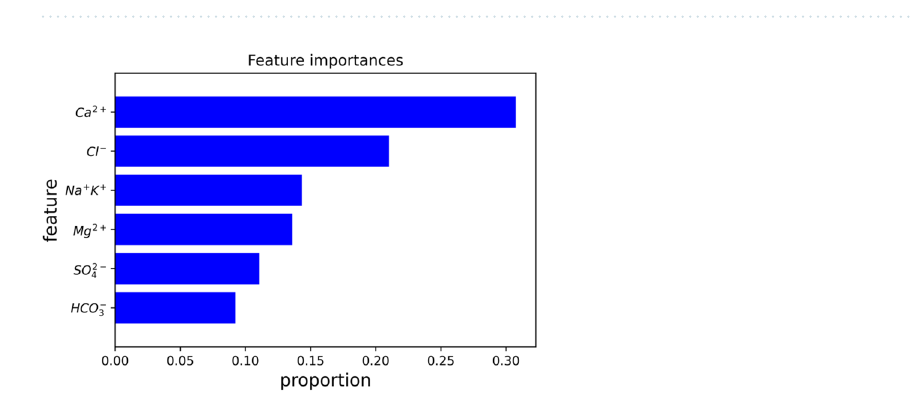
Figure 12. Accuracy and RMSE plot of RF, ANN model and SVM.